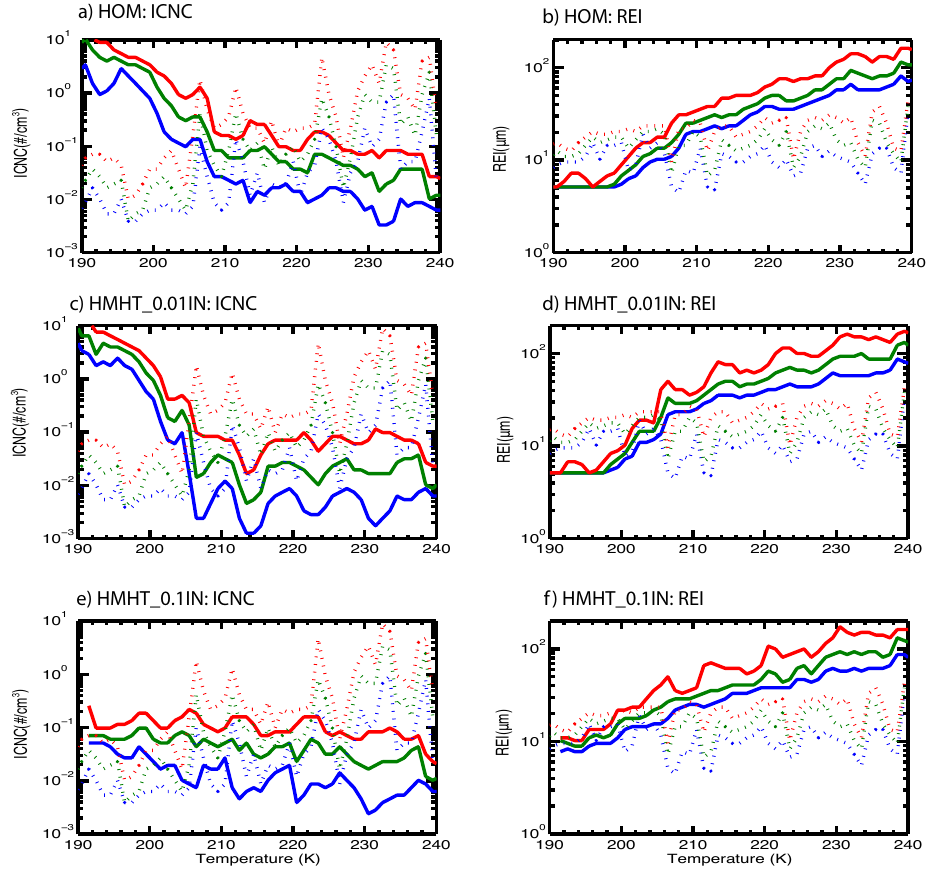
Fig. 5. In-cloud ice crystal number concentration (ICNC, #/cm 3 ) and ice crystal effective radius (REI, µm) versus temperature. Model results are sampled every six hours over six flight regions (Kiruna, Sweden in January and February; Hohn, Germany in November and December; Forli, Italy in Octorber; Mahe, Seychelles, in February and March; Darwin, Australia, in November; Aracabuta, Brazil in January and February) where the observation reported in Kr¨amer et al. (2009) were collected (see Table 3 in Kr¨amer et al. (2009) for the flight information). The 50 percentile (green line), 25% percentile (blue line), and 75% percentile (red line) are shown for each 1K temperature bins. Model results (solid lines) are from the HOM case (a, b), HMHT 0.01IN case (c, d) , and HMHT 0.1IN case (e, f) . Observations (dotted lines) are from data used in Fig. 9 in Kramer et al.